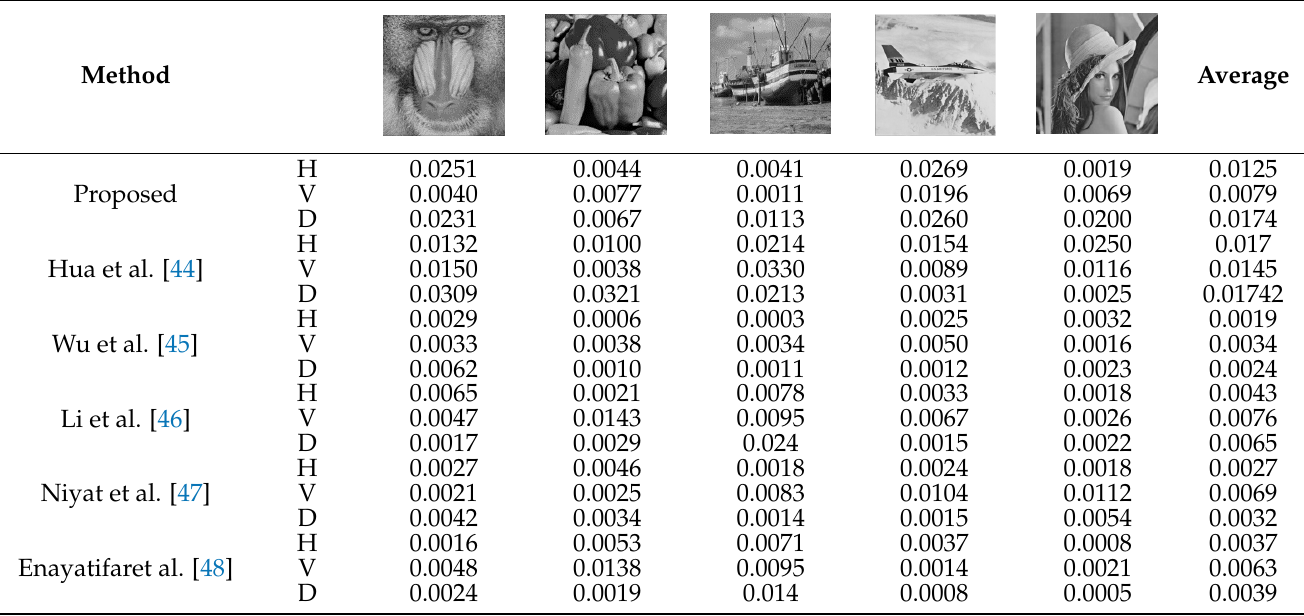
Table 4. Correlation coefficients in three directions: Horizontal (H), Vertical (V), and Diagonal (D) for images with the size of 512 × 512 .